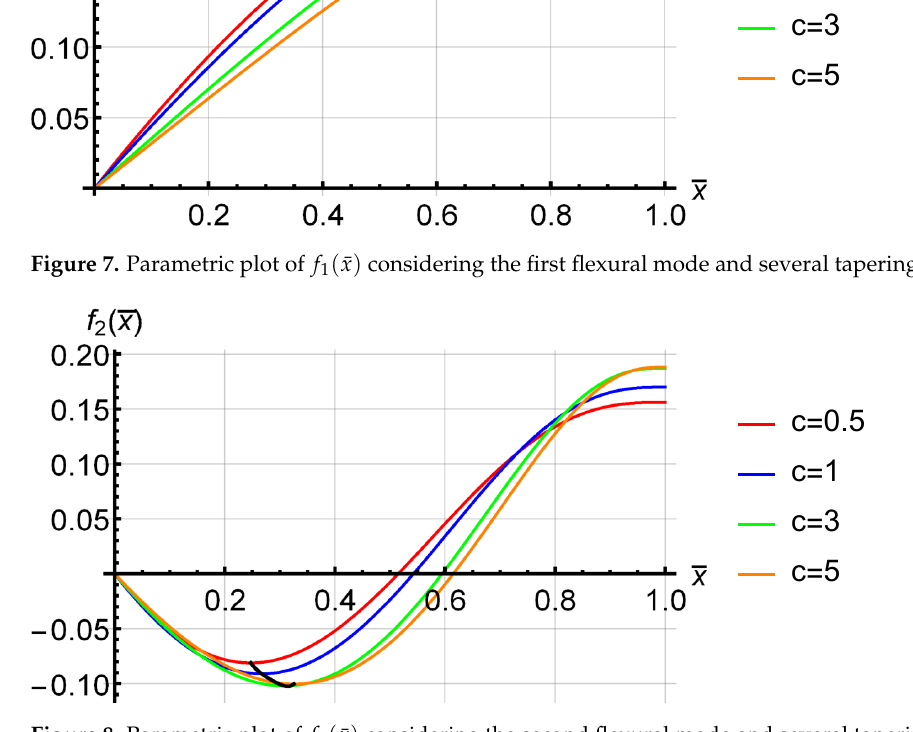
Figure 8. Parametric plot of f 2 ( ¯ x ) considering the second flexural mode and several tapering ratios c . The solid black line highlights the location of the minima of f 2 ( ¯ x ) as c varies.